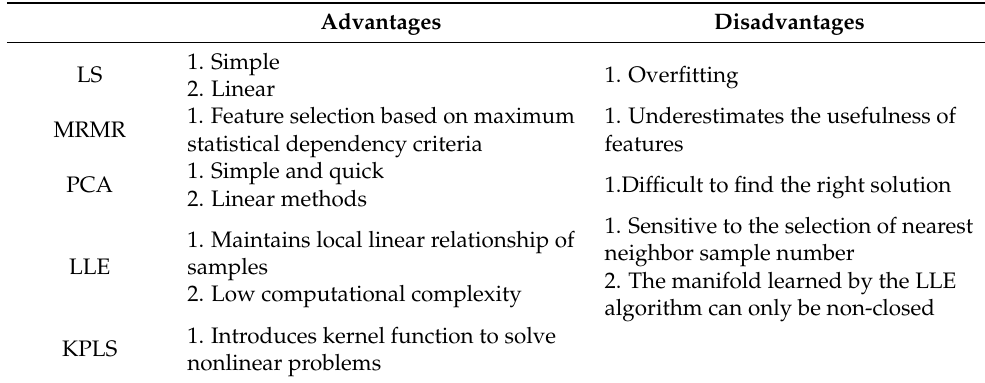
Table 3. The advantages and disadvantages of dimensionality reduction